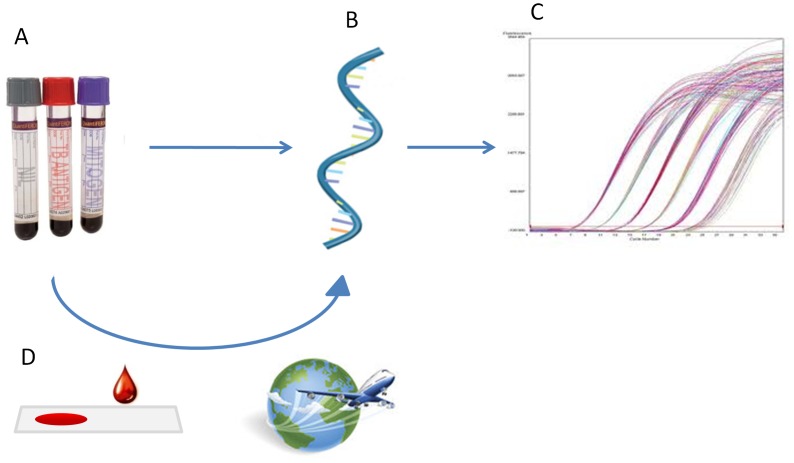
Overview of the RT-qPCR based method for immunodiagnosis of M. tuberculosis infection.A. Blood collection and incubation at 37C. B. Extraction of RNA. C. One-step probe based RT-qPCR and calculation of IP-10 mRNA upregulation using ΔΔCt. D. Optional RNA storage on dried blood spots for easy sample transportation.